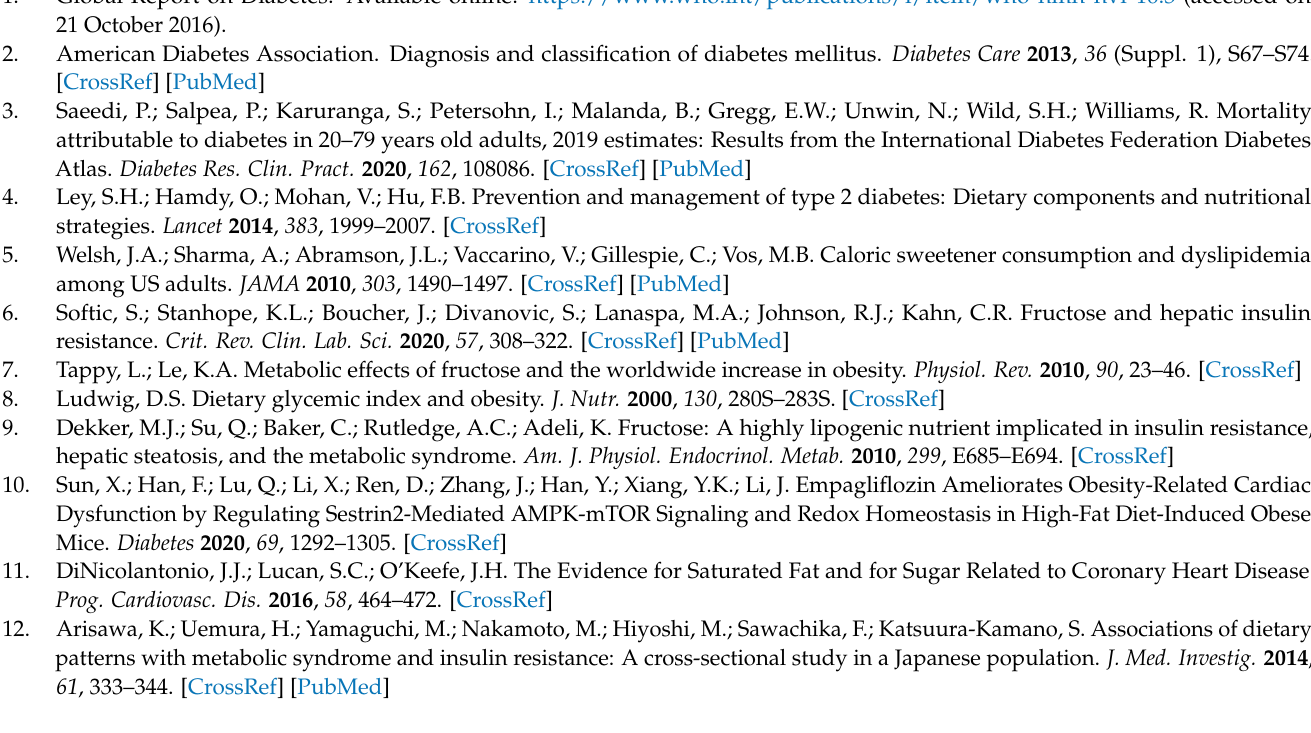
Figure S2: Evolution of hepatic complications in study; Figure S3: Level of pancreas-related endocrine proteins during the intraperitoneal glucose tolerance test (IpGTT); Figure S4: Morphometric analysis of pancreatic islet size and density in this study; Figure S5: Adipocyte infiltration in the pancreas in this study. Figure S6: Basic information from scRNA-Seq Seurat Analysis of diabetic rats. Figure S7: Distinct cell populations with transcriptional signatures in pancreatic cells determined by scRNA-Seq analysis of diabetic rats. Figure S8: Gene Ontology (GO) terms of secretory cells; Figure S9: Distinct cell populations with transcriptional signatures in secretory cells determined by a scRNA-Seq analysis of diabetic rats. Table S1: Ingredients of the diet (%). Table S2: Evolution of physiological, metabolic, oxidative, and inflammatory parameters during the